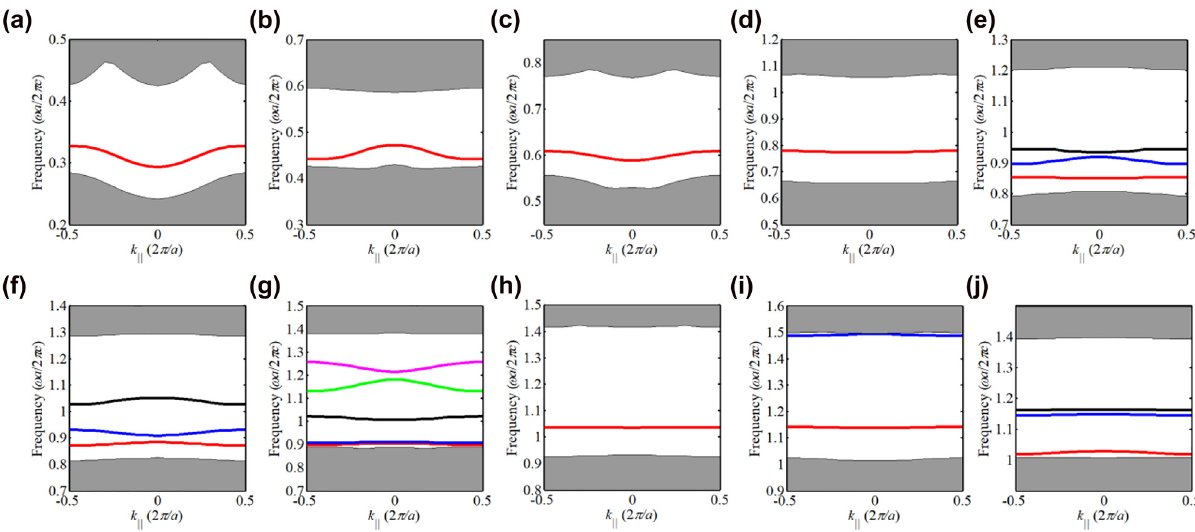
Figure4: Theprojectedbanddiagramsofthesupercellsconsistingof(a)UC1AandUC1B,(b)UC3AandUC3B,(c)UC5AandUC5B,(d)UC7Aand